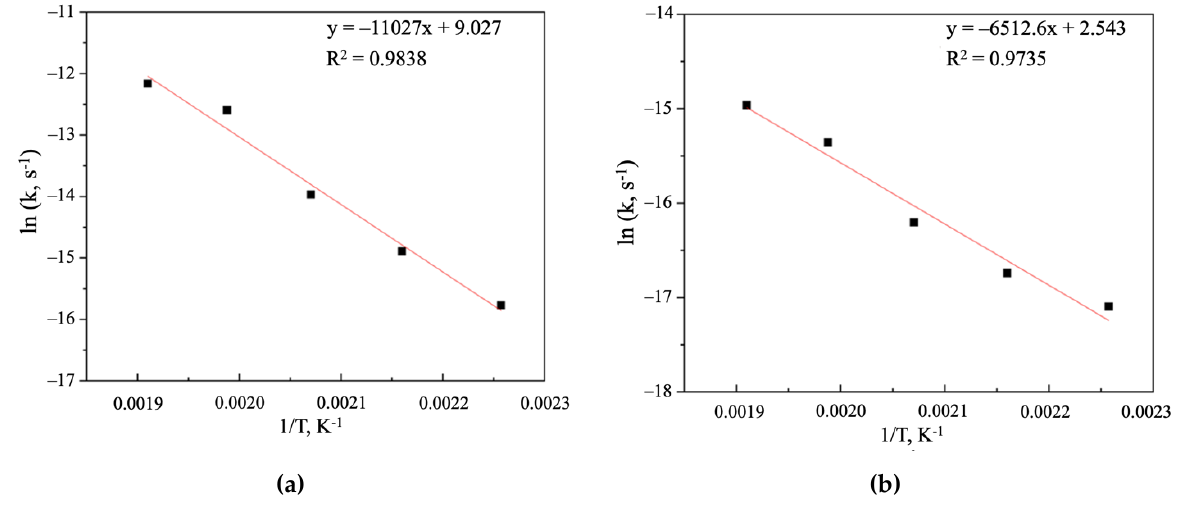
Figure 16. Arrhenius plot for Stage 1 ( a ) and Stage 2 ( b